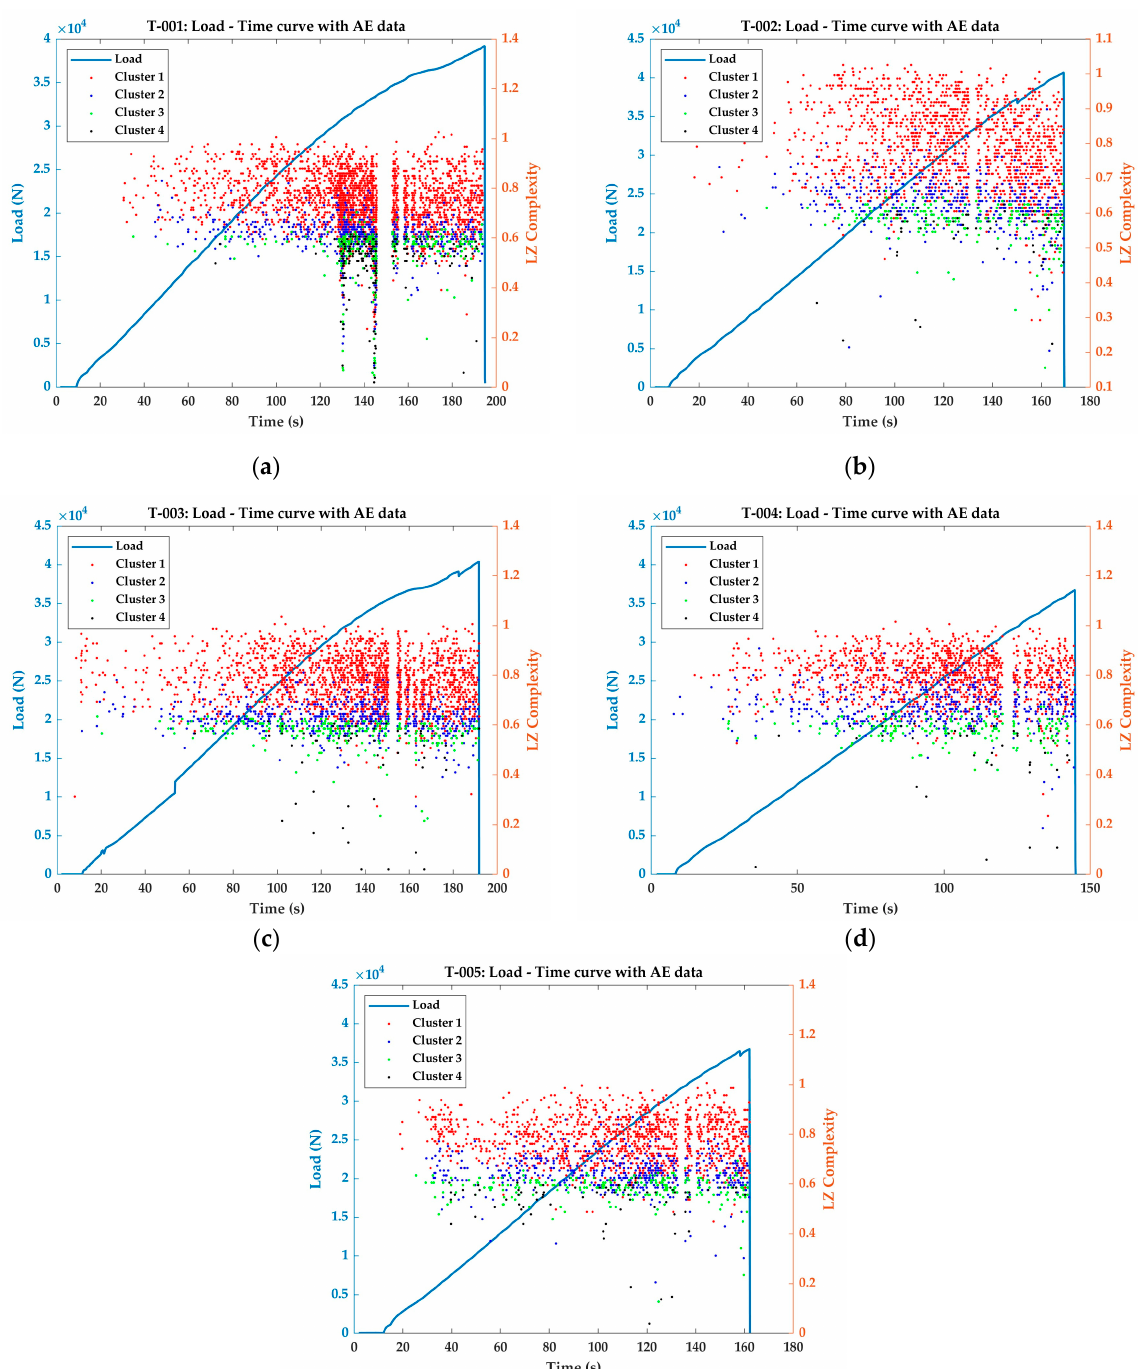
Figure 4. Classified LZ complexities of the AE signals plotted over the load–time curve of the tensile tests ( a ) T ‐ 001; ( b ) T ‐ 002; ( c ) T ‐ 003; ( d ) T ‐ 004; ( e ) T ‐ 005.